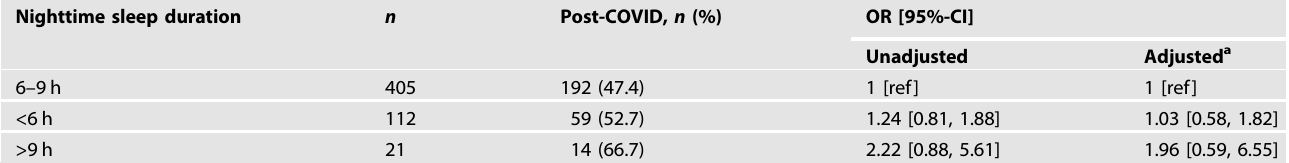
Table 5. Association of habitual nighttime sleep duration with post-COVID among survey respondents who received two mRNA vaccine doses and reported a positive SARS-CoV-2 test